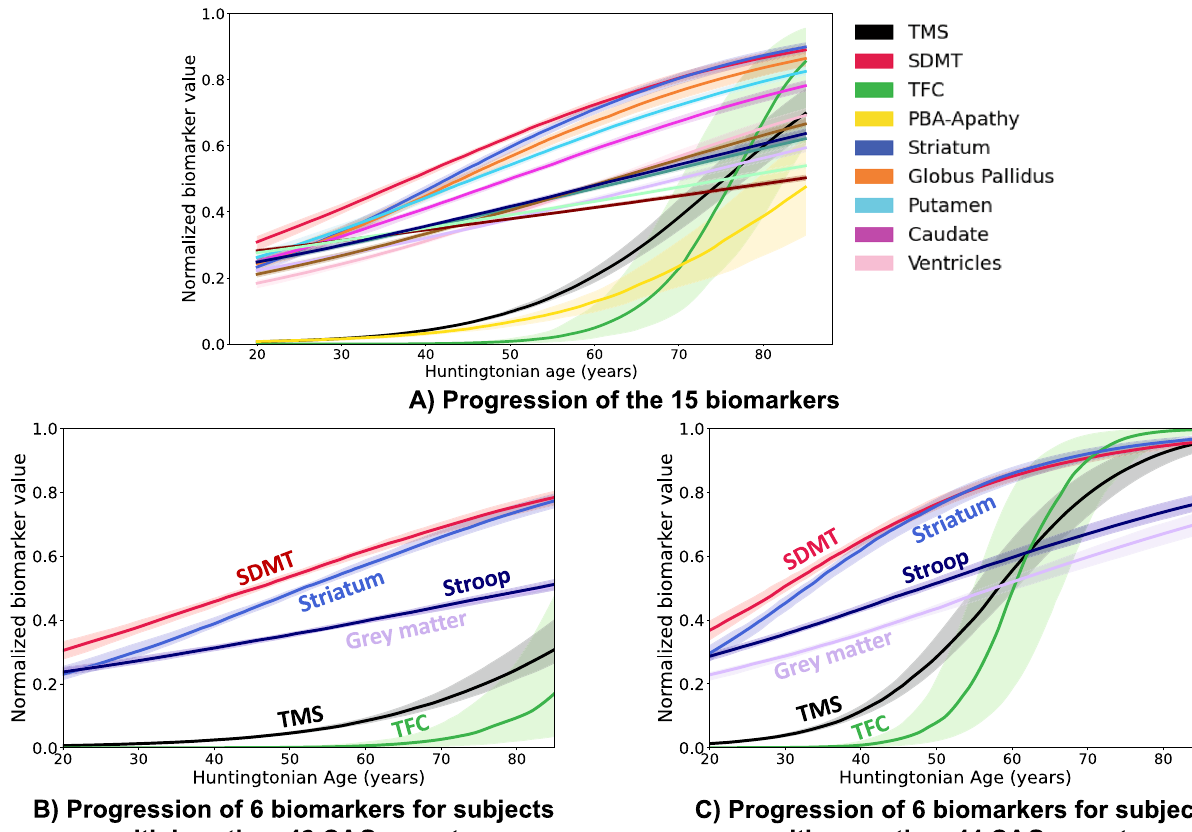
Figure 3. Progression of 15 biomarkers in HD ( A ) The progression estimated from all 290 participants in the TRACK-HD and TRACK-ON studies. Shaded areas correspond to the interquartile confidence intervals around the mean (central curves). Biomarkers have been rescaled so that 0 corresponds the best possible value and + 1 the maximum pathological change (see “Methods” section). Some biomarkers progress in a nearly linear fashion while others exhibit a sharp increase over time. TMS: UHDRS total motor score, Stroop: Stroop Word Reading Test, SDMT: Symbol Digit Modalities Test, TFC: UHDRS Total Functional Capacity, Striatum and grey matter: striatal and grey matter volume. ( B , C ) Typical progression for participants with fewer than 42 CAG repeats ( B ) or more than 44 repeats ( C ) for a selected set of 6